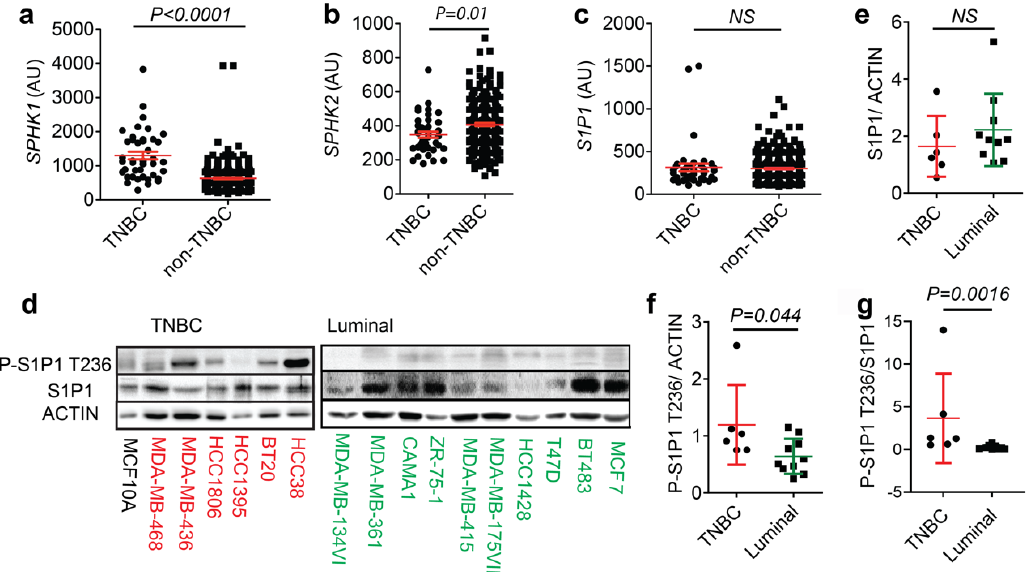
Figure 1. Phospho-S1P1 T236 Levels, but not Total S1P1, are Elevated in Human TNBC Cells. ( a – c ) Relative transcript levels of SPHK1 ( a ), SPHK2 ( b ), and S1P1 ( c ) in human TNBC ( n = 41) and non-TNBC samples ( n = 385) from a reanalyzed microarray dataset (GSE2034; [24]). ( d ) Western blot analysis of phospho-S1P1 T236 (P-S1P1 T236), total S1P1, and ACTIN levels in human TNBC ( n = 6) and luminal ( n = 10) cell lines with MCF10A nontransformed cell line as a control. ( e – g ) S1P1 ( e ) and P-S1P1 T236 ( f ) to ACTIN as well as P-S1P1 T236 to S1P1 ratio ( g ) in TNBC and luminal breast cancer cell lines. Data indicate mean ± SEM.